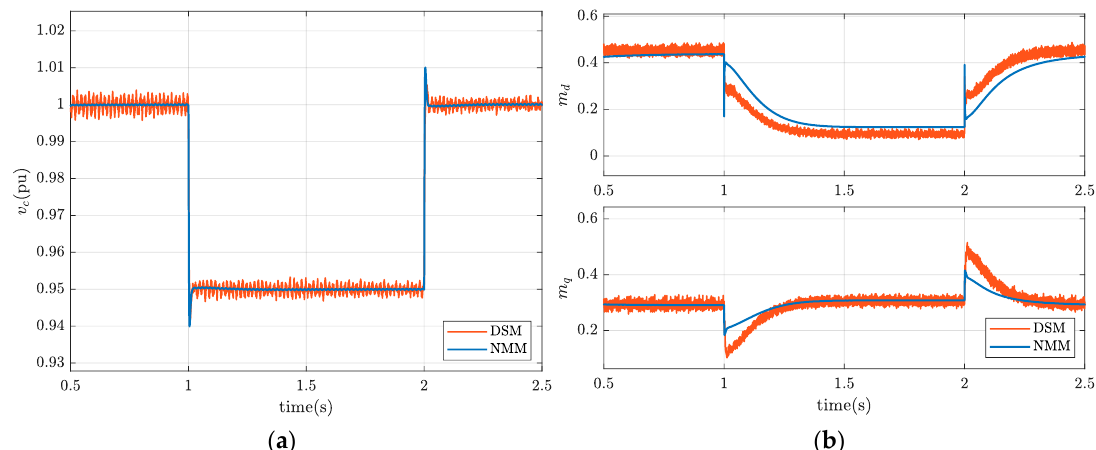
Figure 18. Comparison of the NMM to the DSM for a step change in AC nominal voltage: ( a ) v c and ( b ) m